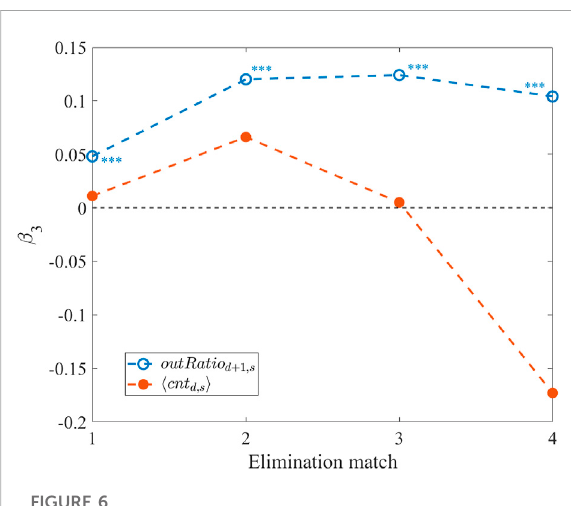
FIGURE 6 The β 3 values with signi fi cance level for DID regressions for user behavioral